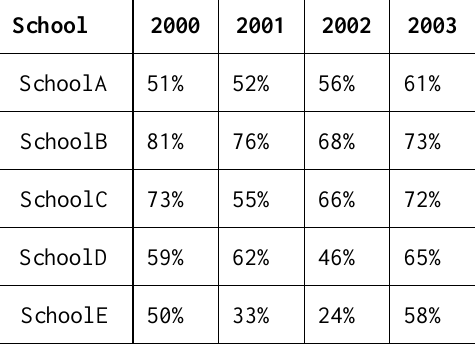
Table 2: Test scores for participating schools